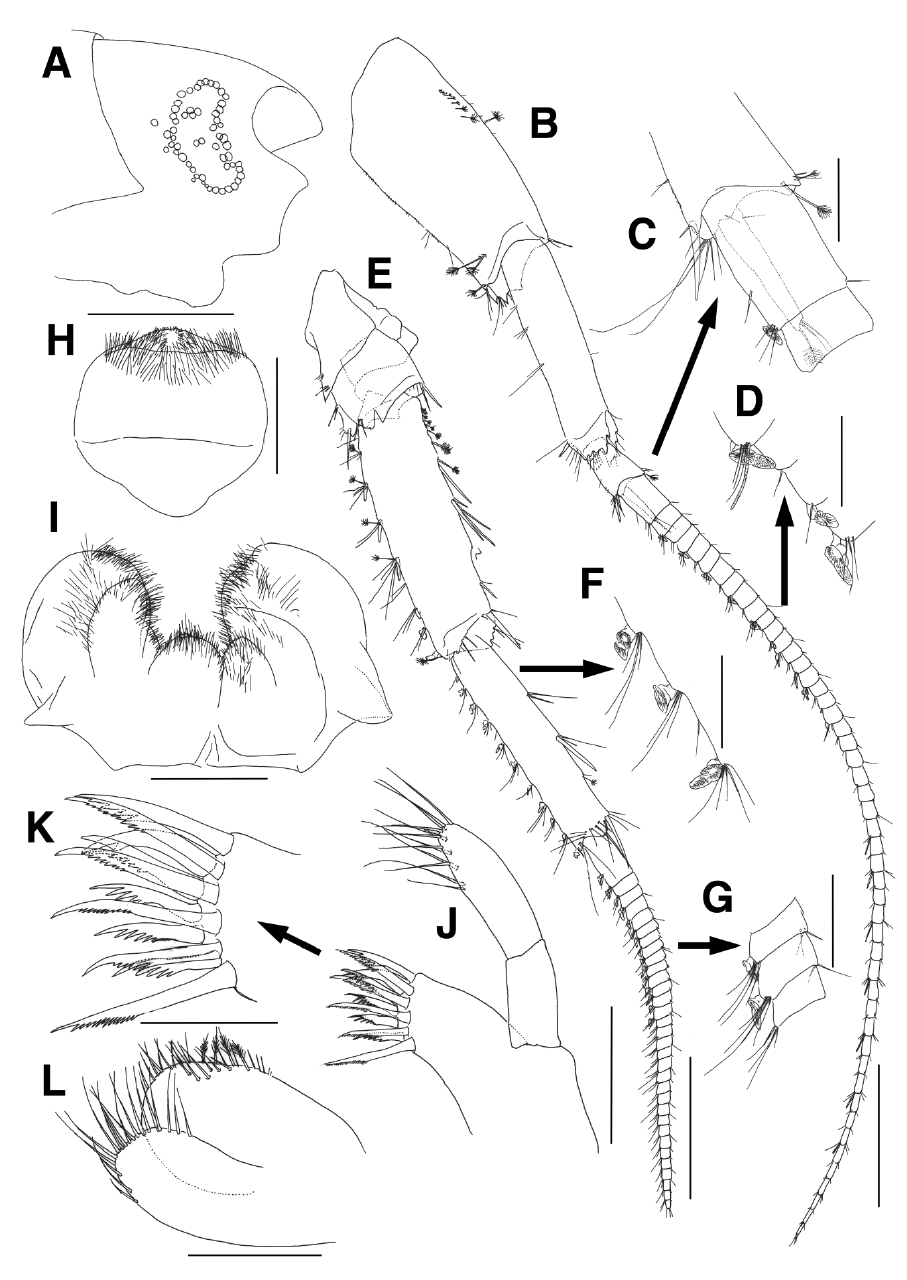
Figure 1. Eusirus bulbodigitus sp. n., holotype, male, NIBRIV0000332003, 11.3 mm. Jeju Island, South Korea. A Head B Antenna 1 C Accessory flagellum D Calceoli of flagellum on antenna 1 E Antenna 2 F, G Calceoli of peduncular article 5 and flagellum on antenna 2 H Upper lip I Lower lip J Maxilla 1 K Setae of outer plate on maxilla 1 L Maxilla 2. Scale bars=0.1 mm ( C, D, F, G, K ), 0.2 mm ( H–J, L ), 0.5 mm ( A, B, E